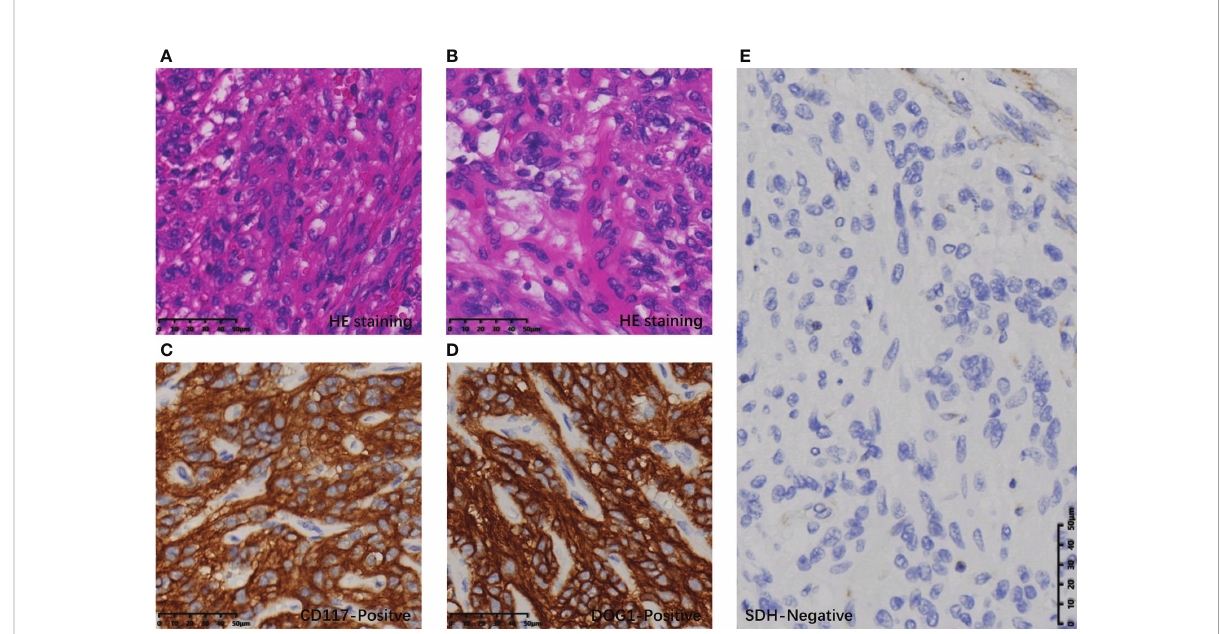
FIGURE 3 Histopathological and immunohistochemical results of GIST: (A) Spindle-shaped tumor cells on HE staining. (B) Epithelioid tumor cells on HE staining. (C) Tumor cells with diffuse CD117 positivity. (D) Tumor cells were diffusely positive for DOG1. (E) Tumor cells were diffusely SDH negative under the SDH positive control of vascular endothelial